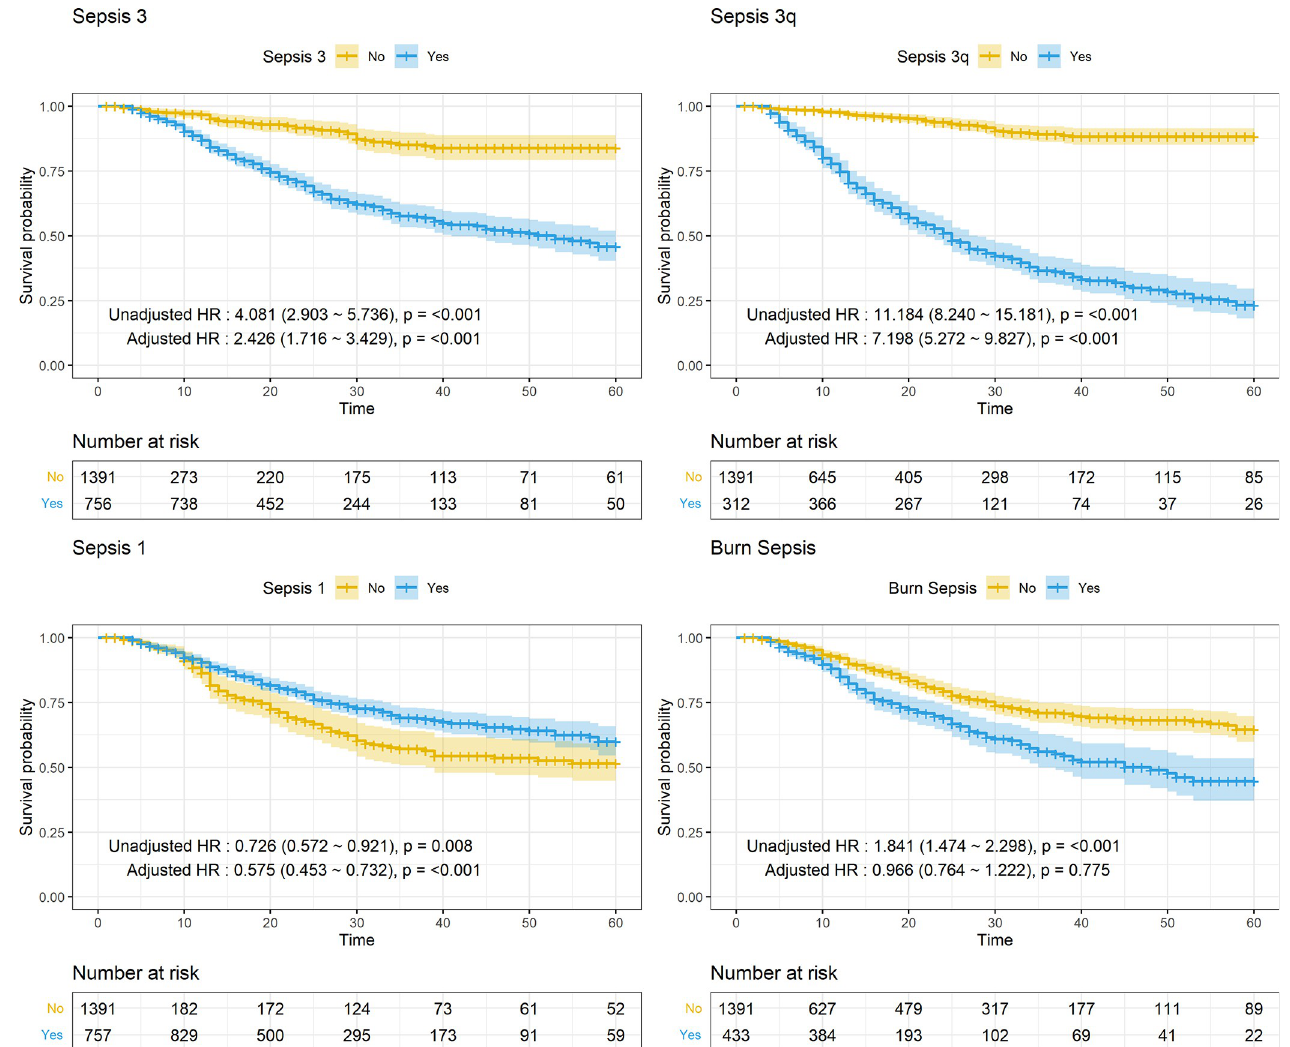
Fig 2. Survival curves (Kaplan-Meier) and unadjusted/adjusted HR of each sepsis criterion related to the 60-day mortality in burned patients with suspected infection. (A) Sepsis-3. (B) Sepsis-3q. (C) Sepsis-1. (D) Burn Sepsis.